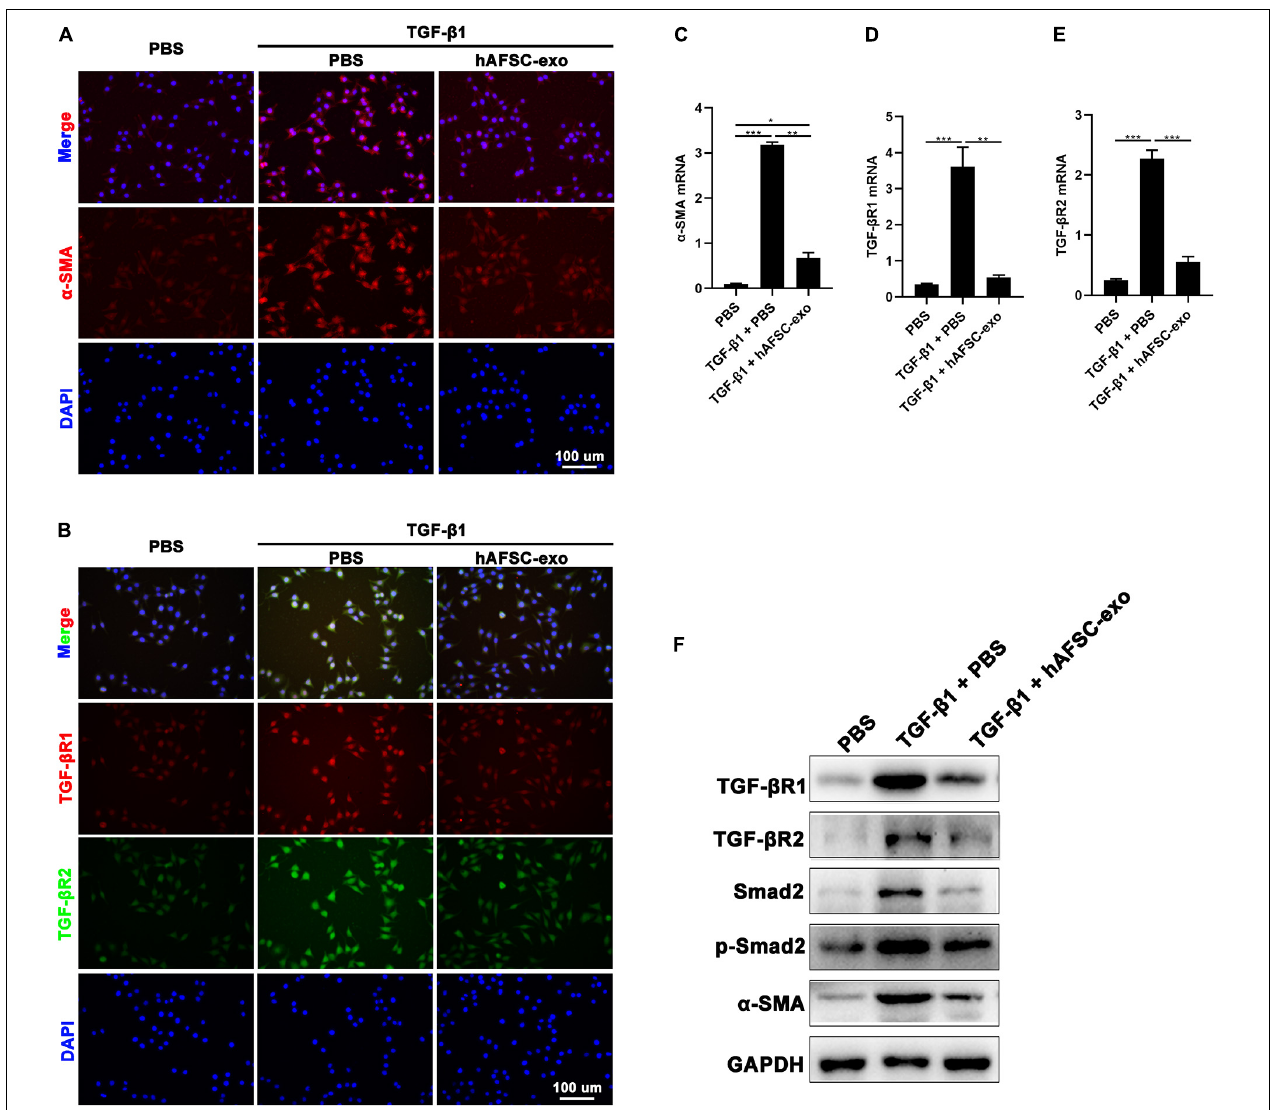
FIGURE 7 | hAFSC-exo inhibited TGF- β -induced myofibroblast formation in vitro . HDFs were cultured for 48 h with TGF- β 1 (25 ng/ml) to induce myofibroblast differentiation. Some of the cells were also treated with hAFSC-exo (10 ng/ml). (A,B) IF staining of α -SMA, TGF- β R1, and TGF- β R2 in HDFs (scale bar = 100 µ m). (C–E) qRT-PCR analysis of α -SMA, TGF- β R1, and TGF- β R2 in HDFs. (F) Western blot analysis of TGF- β R1, TGF- β R2, Smad2, p-Smad2, and α -SMA in HDFs. Mean ± SD; * P < 0.05; ** P < 0.01; *** P < 0.001; n = 3. HDFs, human dermal